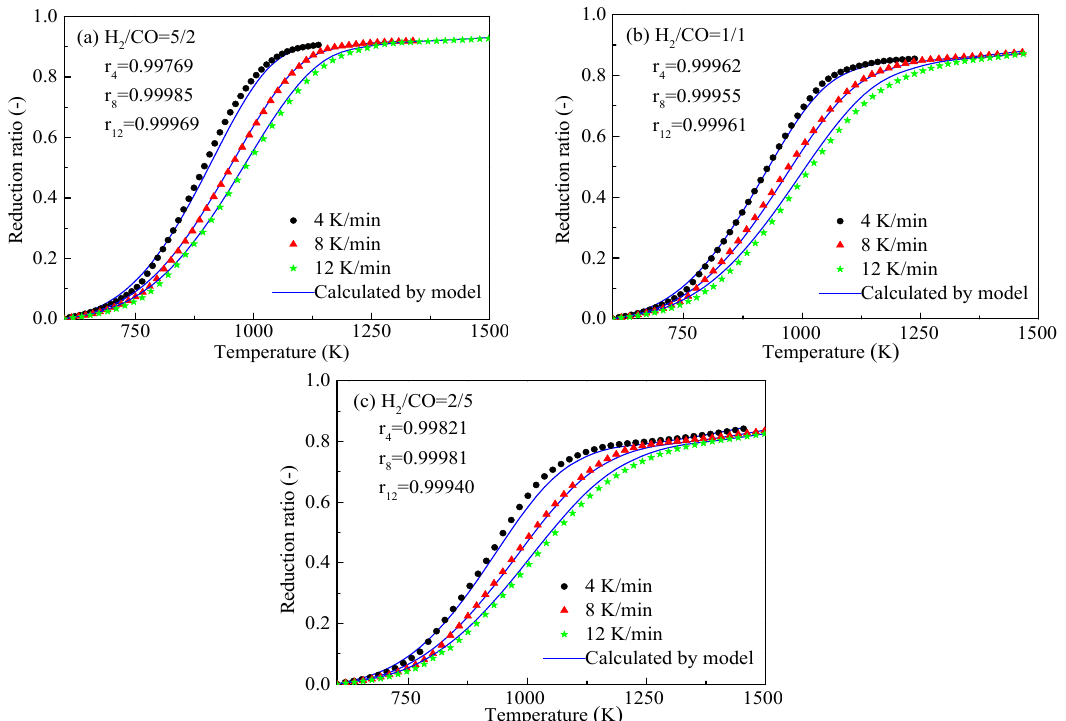
Figure 16. Comparison between the experimental and calculated non-isothermal reduction ratio with different heating rates ( a ) H 2 /CO = 5/2; ( b ) H 2 /CO = 1/1; ( c ) H 2 /CO = 2/5.